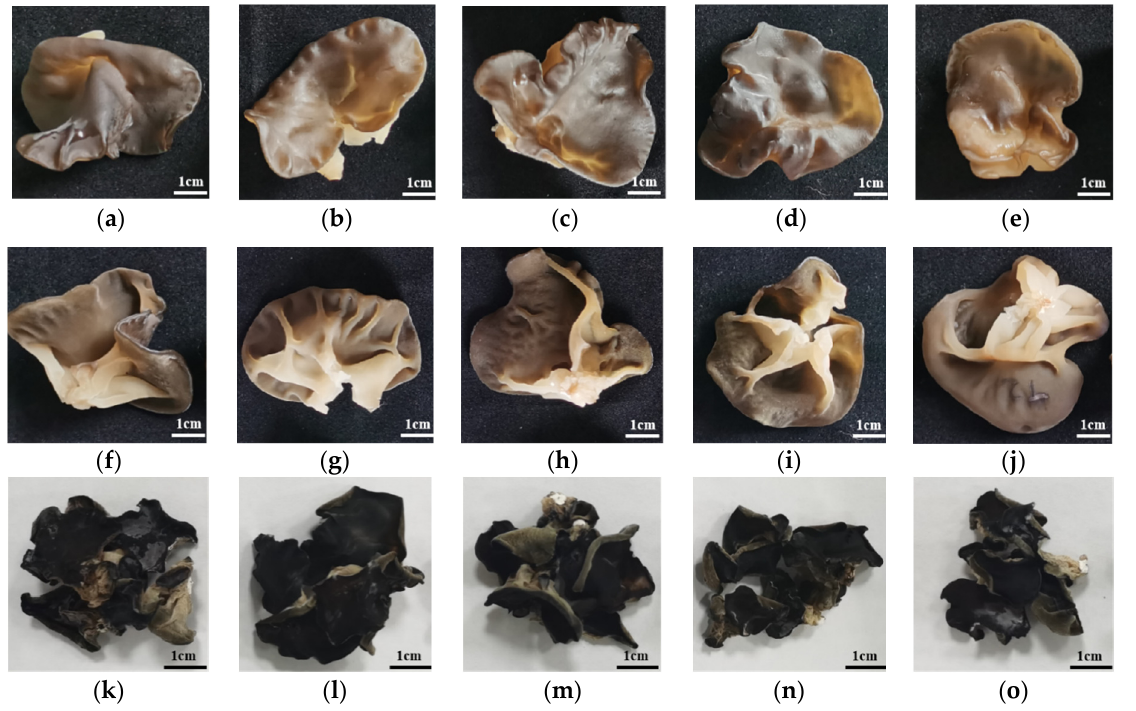
Figure 4. The ratio of miscellaneous sawdust and walnut sawdust was 4:0, 3:1, 2:2, 1:3, and 0:4 of A. auricula on the fresh front ( a – e ); fresh back ( f – j ) and dried sample ( k – o ).